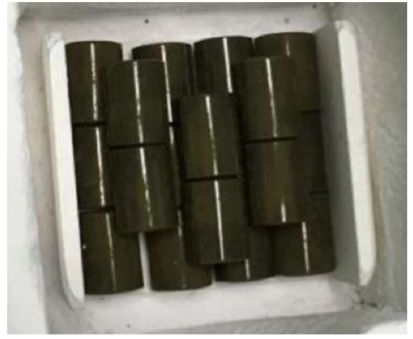
Figure 4. Location of fuel pellets in the support plate in the horizontal position.